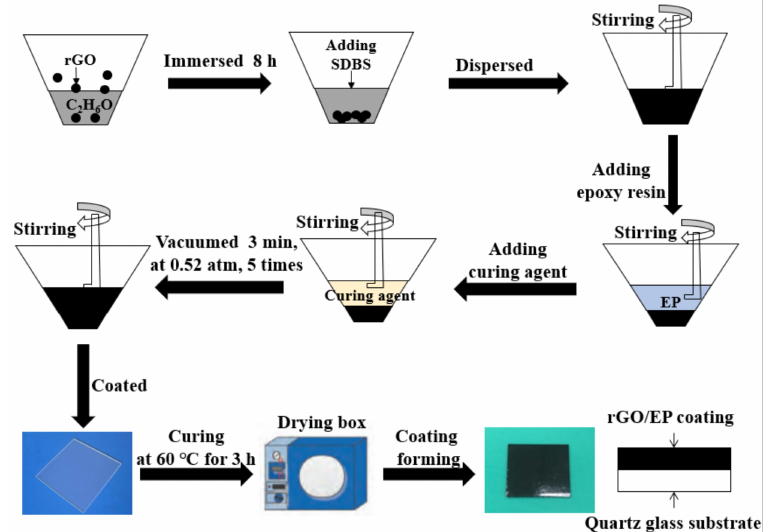
Figure 1. Preparation flowchart of the rGO/EP